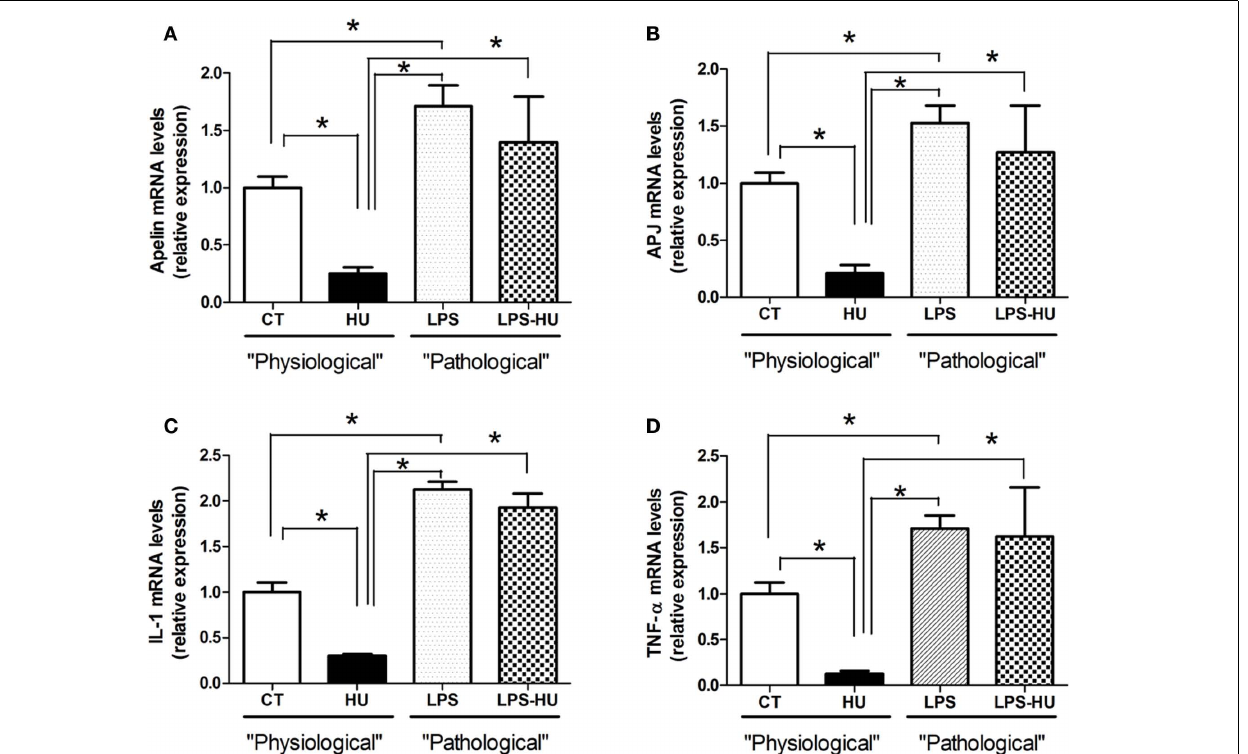
adipose tissue explants from lean mice exposed to vehicle (CT), LPS (LPS) or cannabinoid receptor agonist HU-210 (HU; 100 nM) alone or in combination with LPS (100 ng.ml, LPS-HU) for 24h. * indicates P < 0.05 for the drug effect; by a two-tailed Student’s t